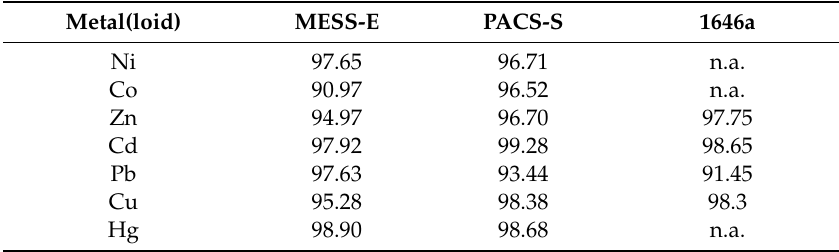
Table 2. Recovery rate (%) for the metals analyzed in this study compared to the reference values using three reference materials (MESS-E, PACS-S and